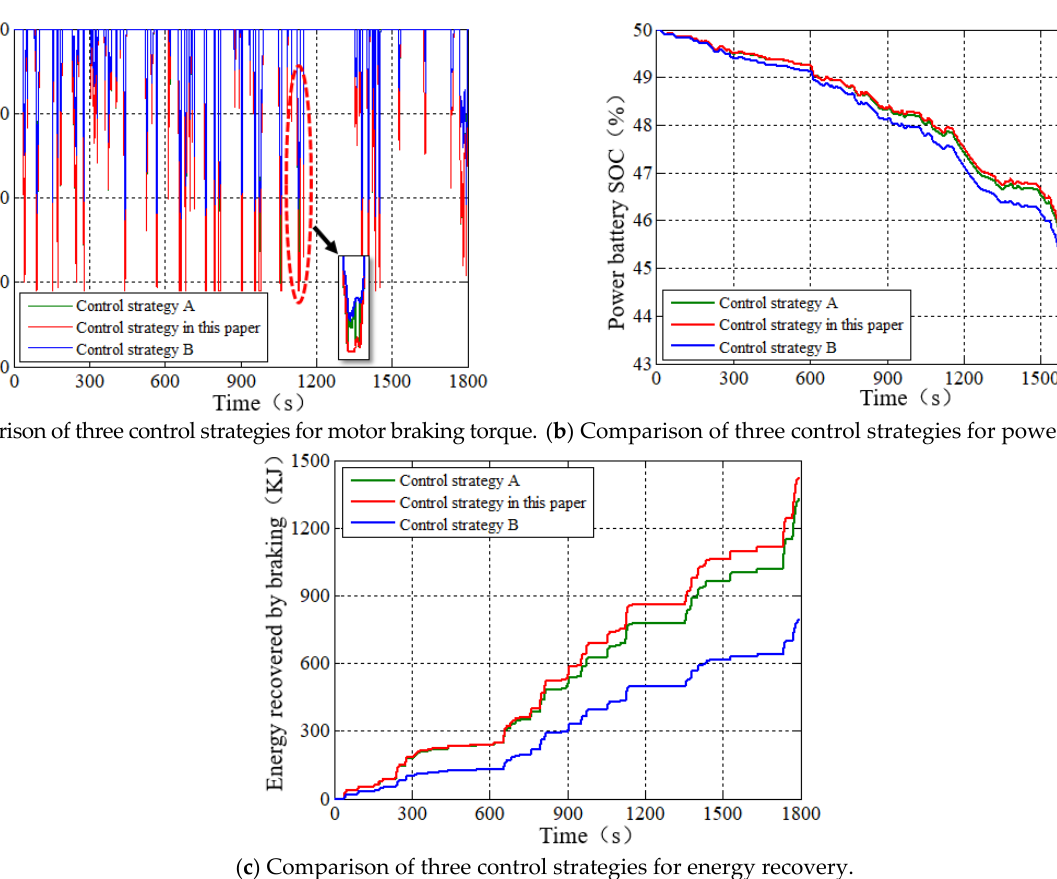
Figure 20. Comparison of three control strategies in the WLTC condition.